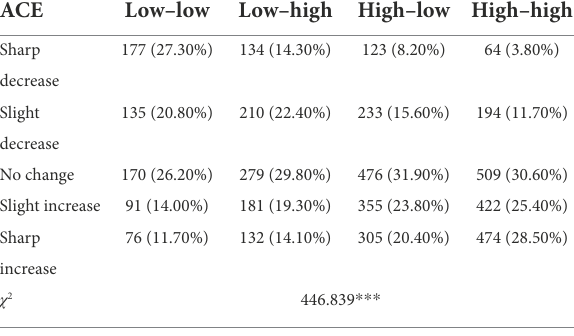
TABLE 6 Association between profiles and ACE. ACE Low–low Low–high High–low